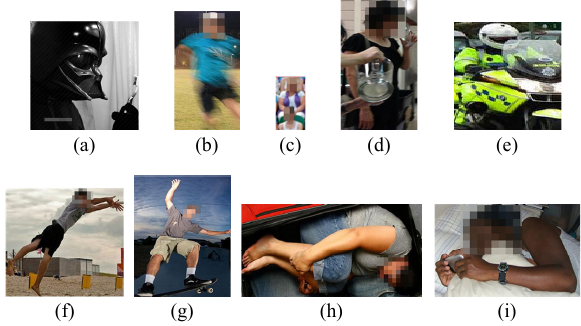
Figure 2. Some images in the LIP data set are not suitable to be used as the foreground, such as (a) black-and-white image; (b) blurred image; (c) low resolution image; (d) severe occlusion image, and (e) the image with no body parts exposed. (f)-(i) are good image samples we keep to generate composite images. We blur faces for privacy